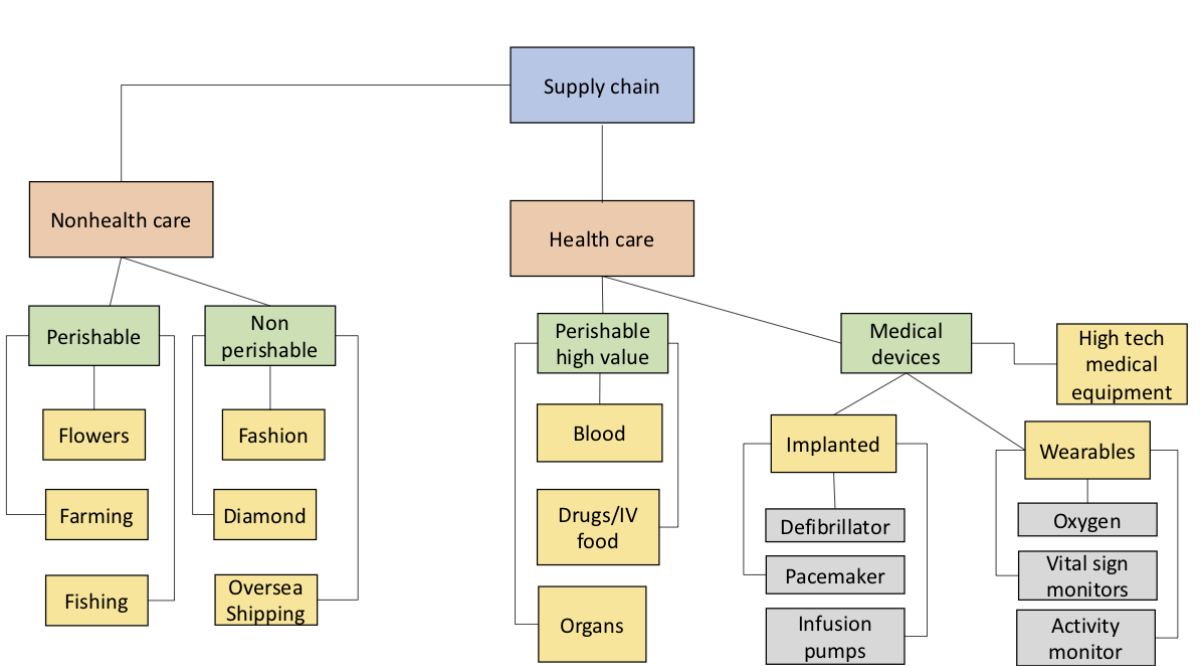
Figure 4. Supply chain tree. IV: